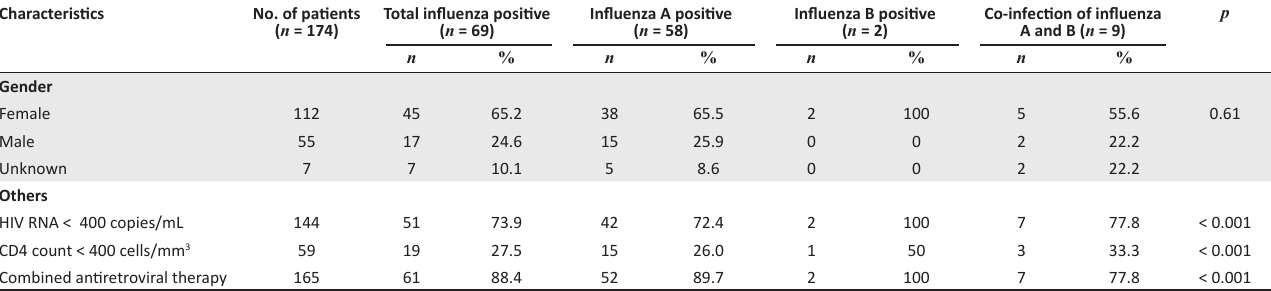
TABLE 1 : Characteristics of HIV patients positive for influenza A and B viruses in 2018 in a university-based HIV clinic in Lagos, Nigeria. Characteristics